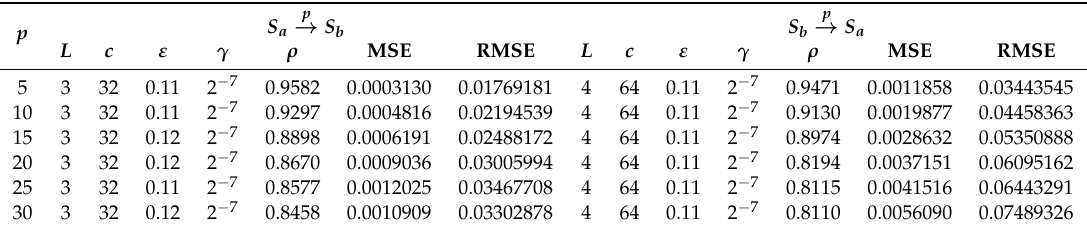
Table 2. Values of the parameters for the best models for each prediction interval according to the training set and test.